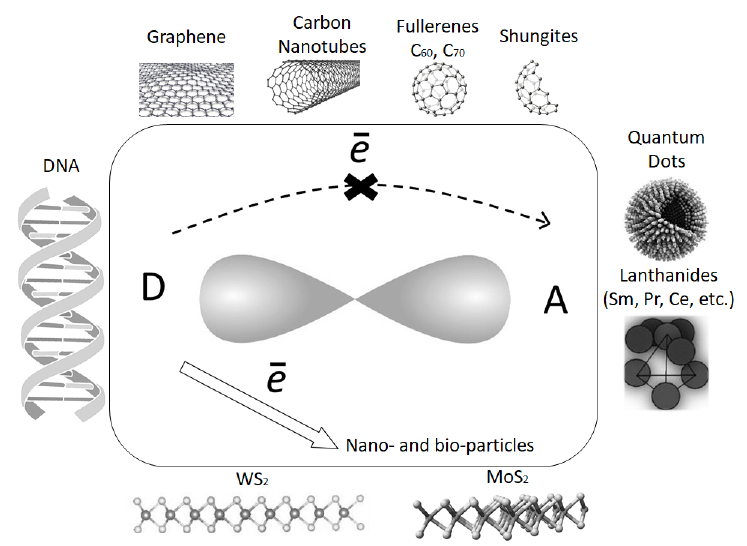
Figure 2. A model showing the formation of the intermolecular CTC.